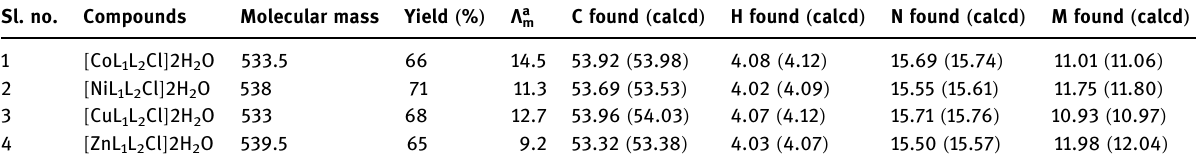
Table 1: Physicoanalytical data of the compounds Sl.